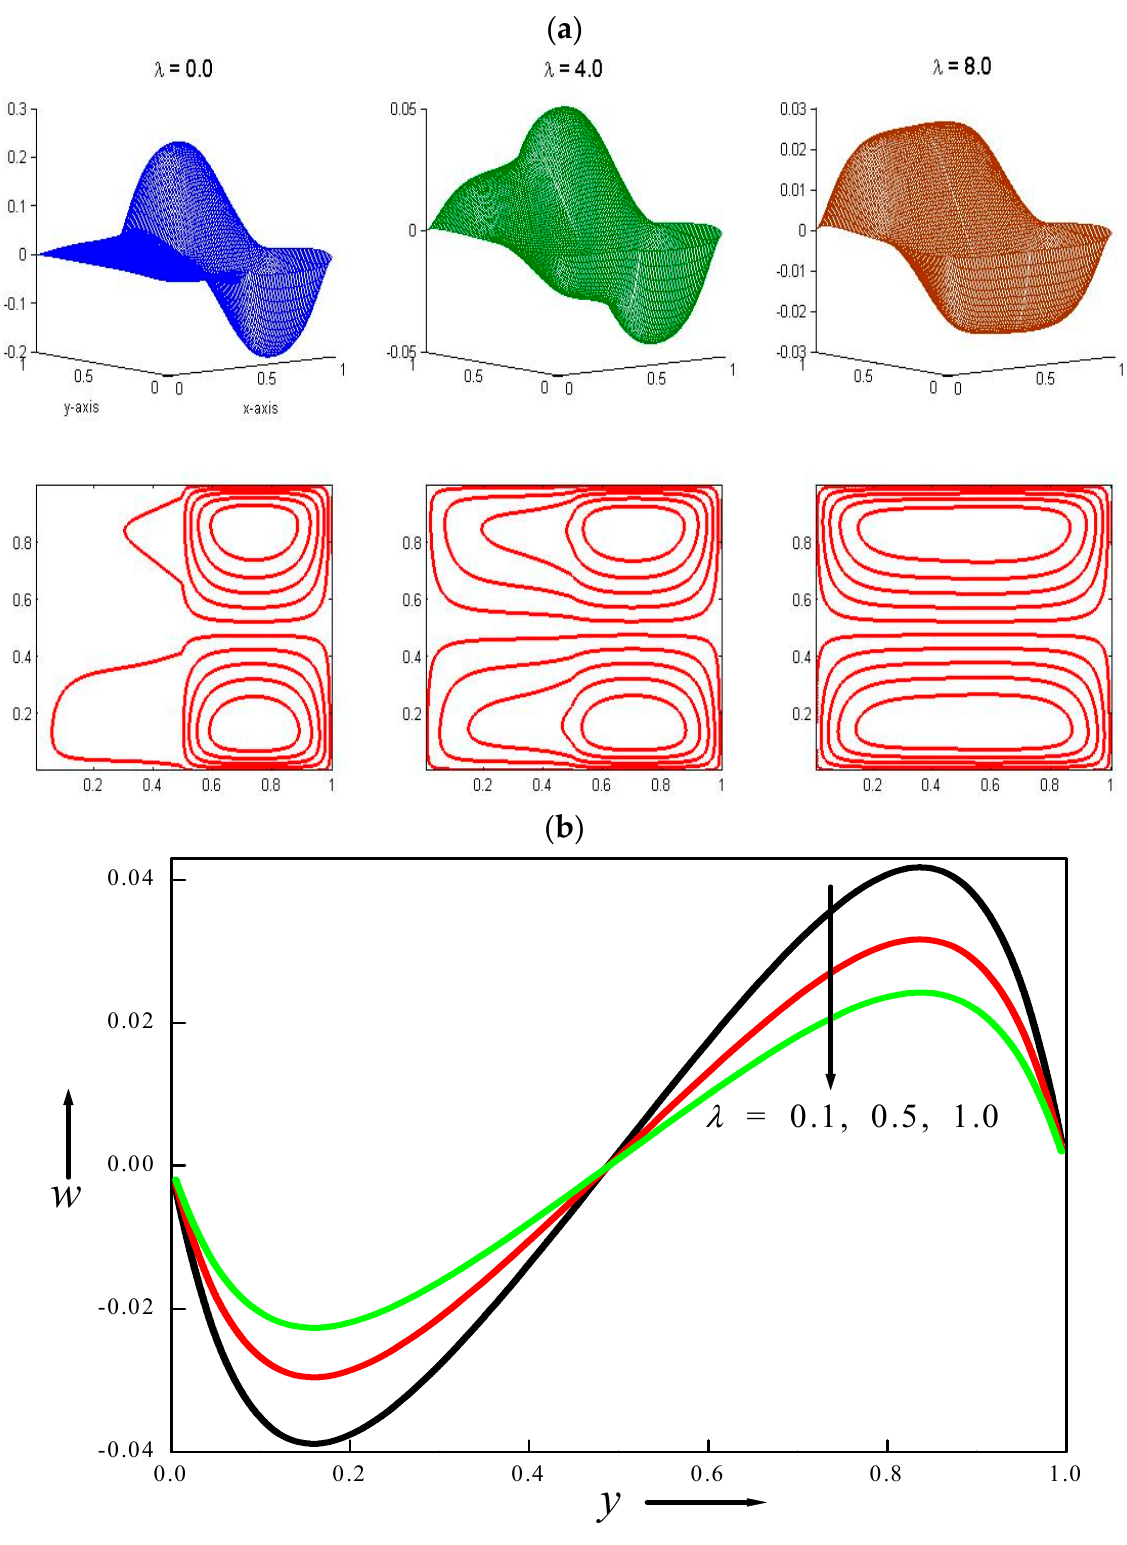
Figure 8. Velocity ( a ) contours and ( b ) profiles for altered ratio of viscosities.